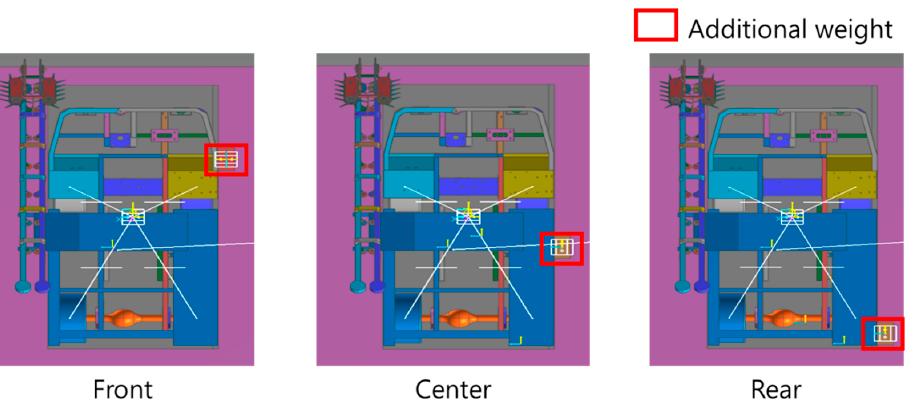
Figure 7. The location of the additional weights installed in the self-propelled radish harvester at the front, center, and rear. front, center, and